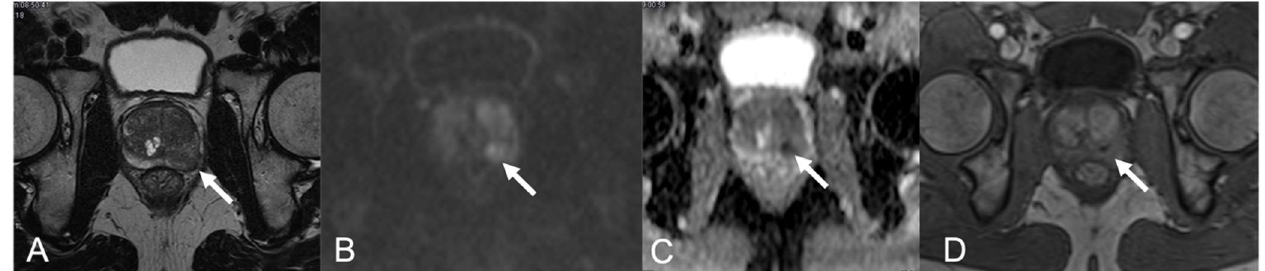
Figure 6. BCG-GP in a 62-year-old patient (case 8). MpMRI shows diffuse alteration of the left middle lobe peripheral zone with capsular bulging (arrow in ( A )), with a marked hypointense 1-cm nodule markedly hyperintense on DWI (arrow in ( B )), with marked low ADC value (arrow in ( C )) and with an early and persistent peripheral rim enhancement and avascular core (arrow in ( D )). PIRADS v2.1 5 PZpm mid-base left.